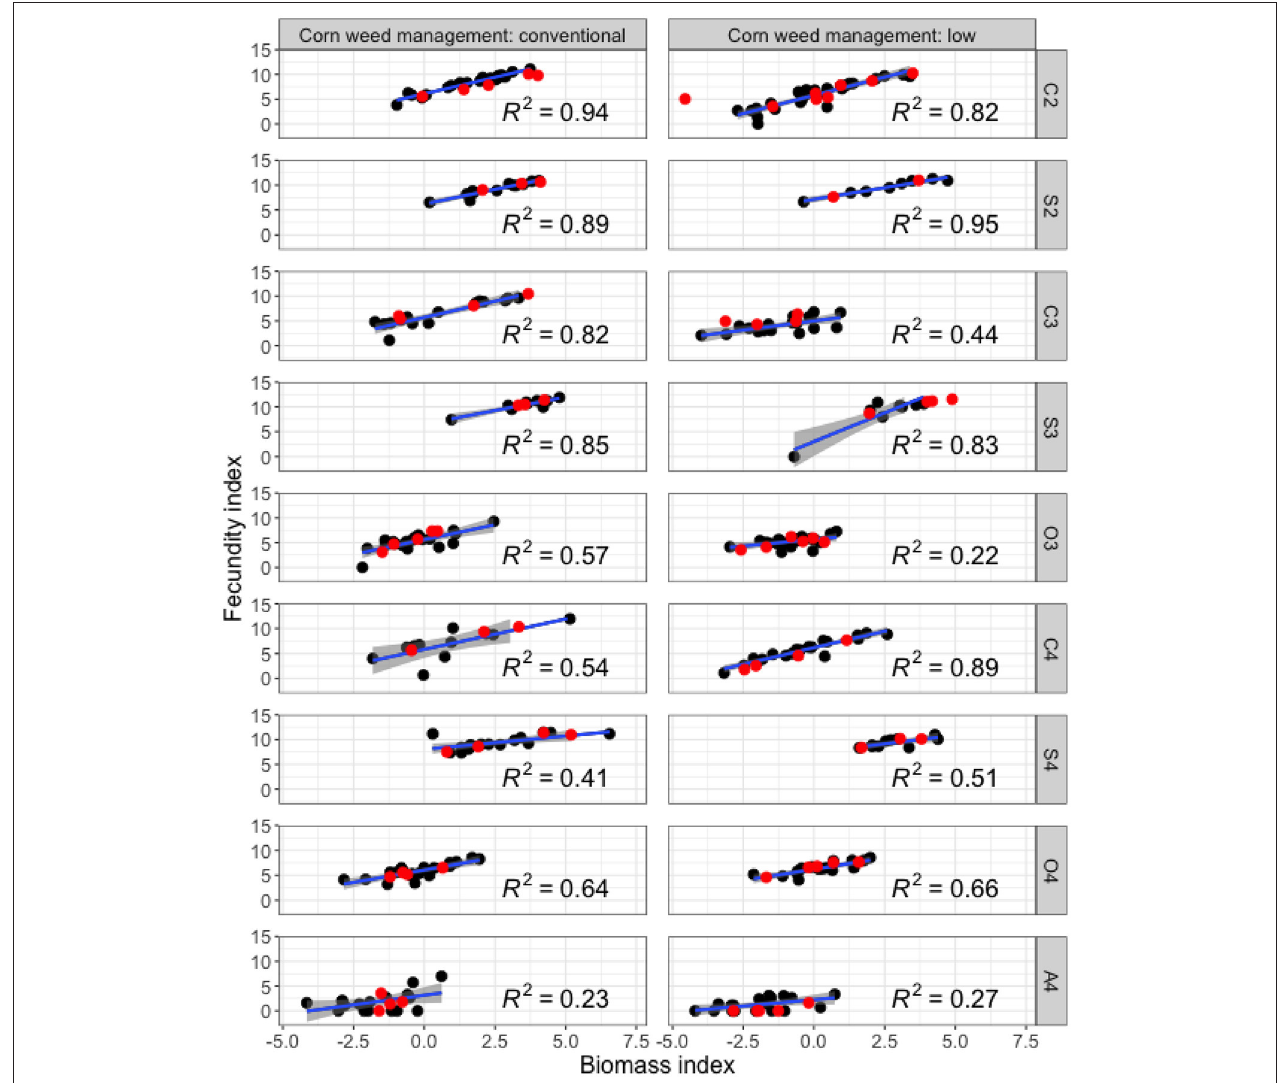
FIGURE 5 | Estimation of fecundity using aboveground mass. The abbreviations on the right-hand-side y -axis are crop identities, which are the combinations of the first letter in crop species names and the rotation to which the crops belonged (C2, corn in the 2-year rotation; C3, corn in the 3-year rotation; C4, corn in the 4-year rotation; S2, soybean in the 2-year rotation; S3, soybean in the 3-year rotation; S4, soybean in the 4-year rotation; O3, oat in the 3-year rotation; O4, oat in the 4-year rotation; and A4, alfalfa in the 4-year rotation). The black and red dots are values from training and testing sets, respectively. Each regression line was plotted for one crop identity by herbicide treatment using the training set. R 2 values were calculated from the training set only, and thus, were slightly different from those in Table 9 . Biomass index = ln(gram biomass + 0.005) and Fecundity index = ln (seeds +